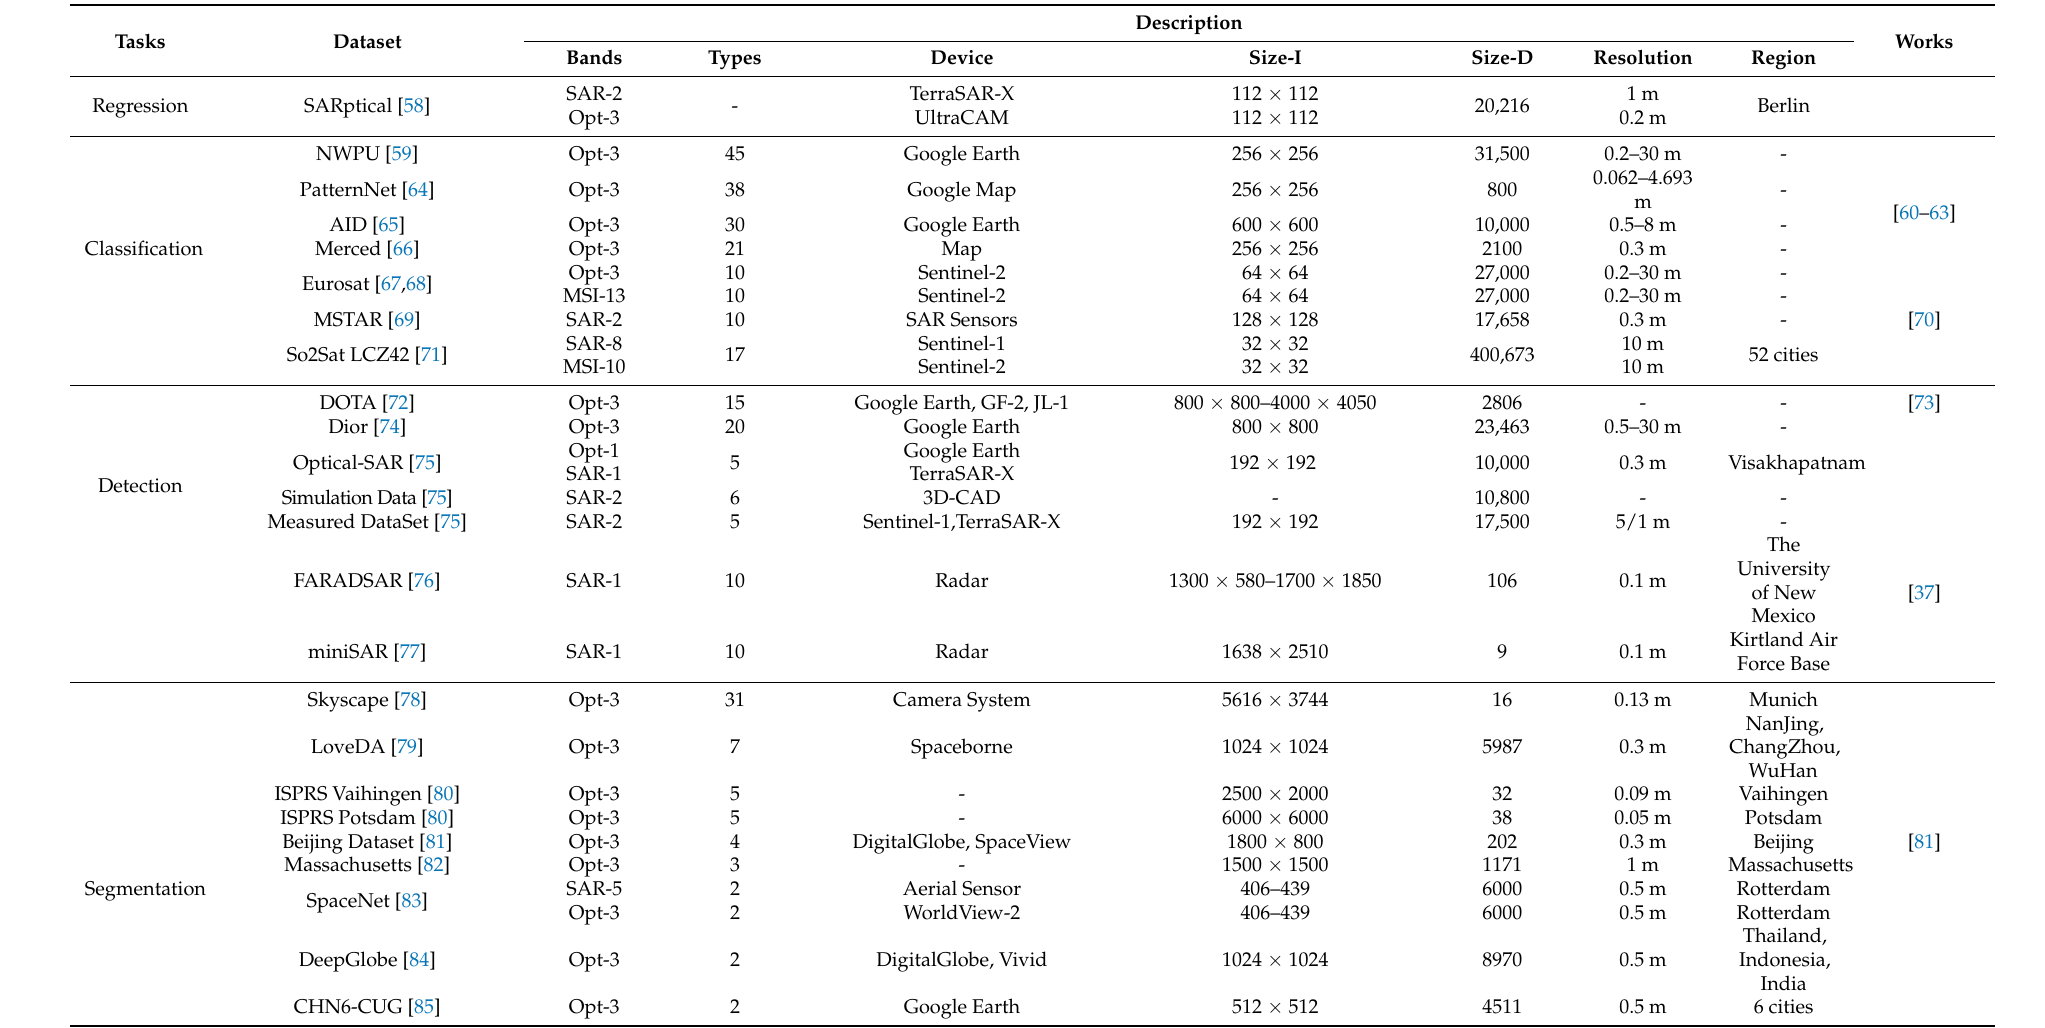
Table 1. Some remote sensing datasets used in unsupervised domain adaptation